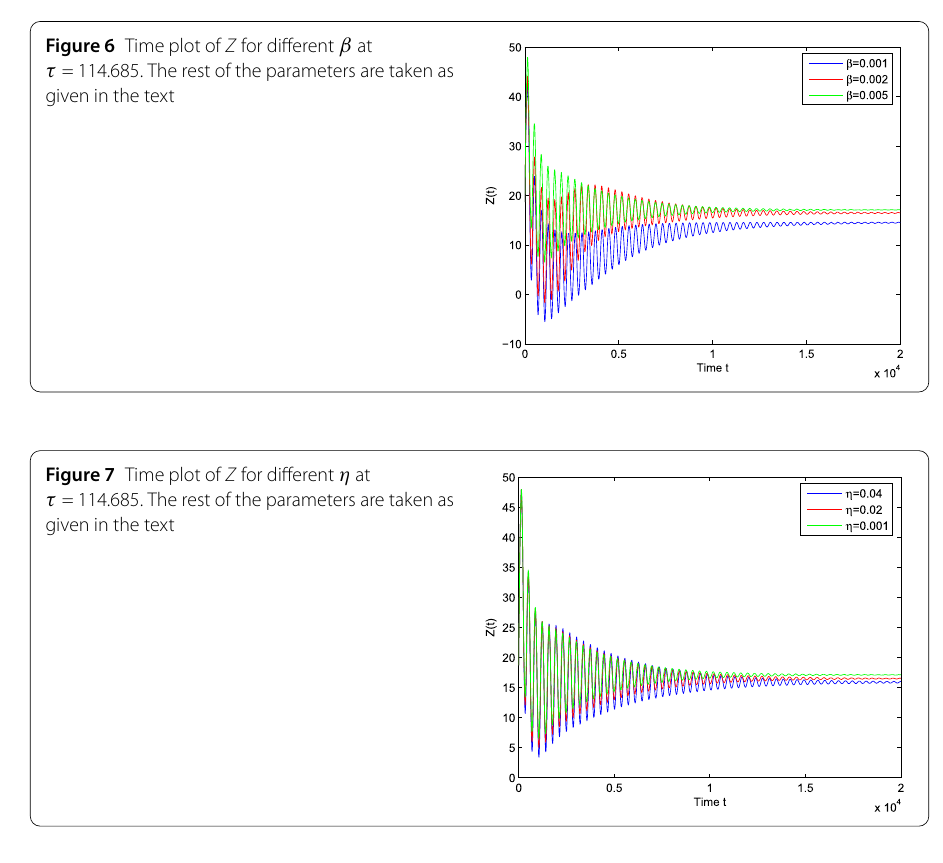
Figure 8 Time plot of Z for different ζ at τ = 114.685. The rest of the parameters are taken as given in the text